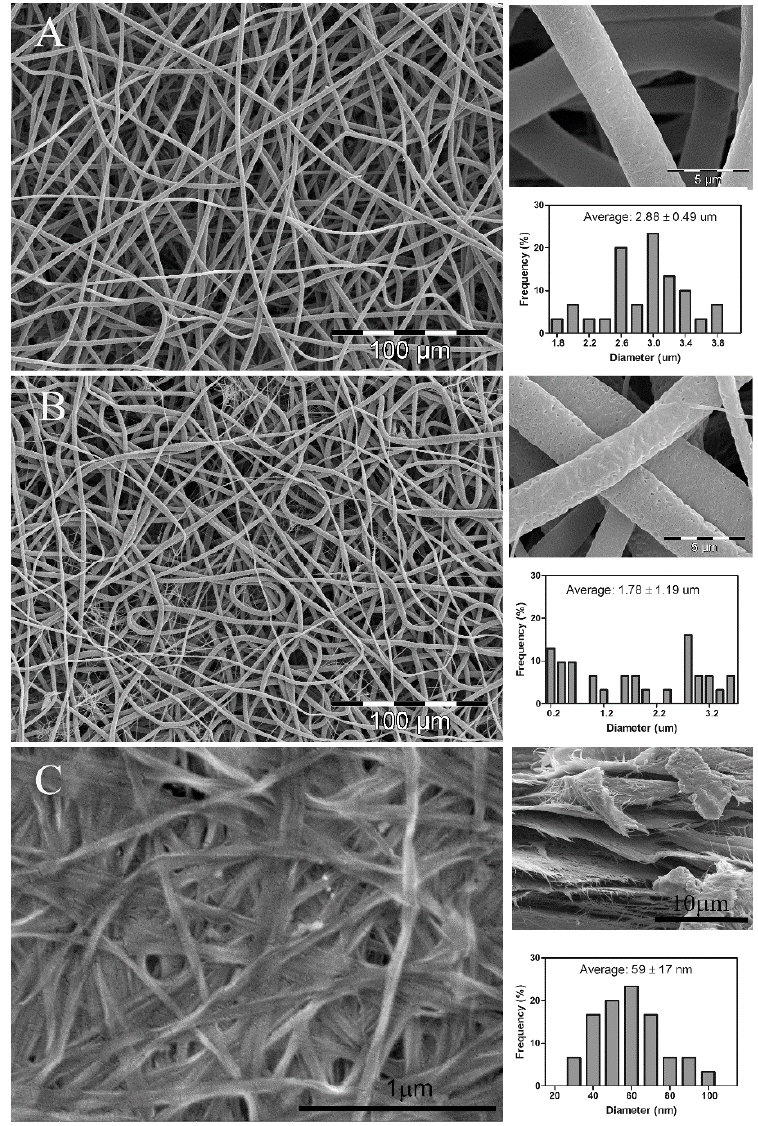
Figure 1. SEM images and fiber diameter distribution of nanofibers. ( A ) PLA from 8 wt % PLA in chloroform/acetone (3:1, v / v ) solution; ( B ) PLA/Lip from 8 wt % PLA in chloroform/acetone (3:1, v / v ) containing 5% lipids (PLA w / w ); ( C ) BC sample surface.